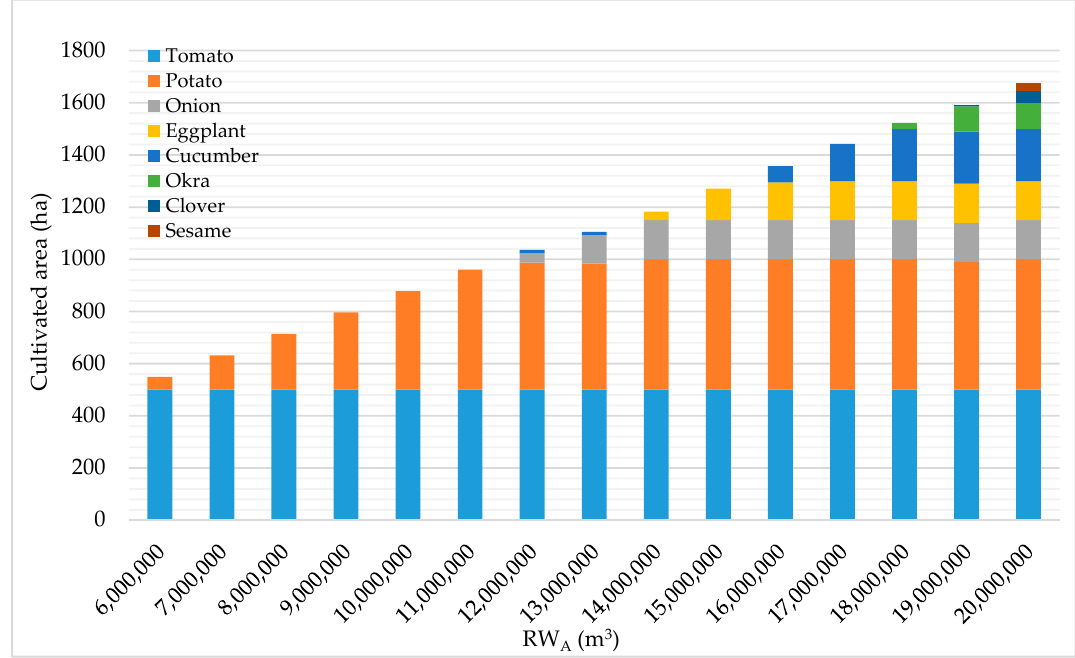
Figure 9. Predicted area (ha) of crops irrigated using reclaimed water type A (RW A ) with 65% IE.